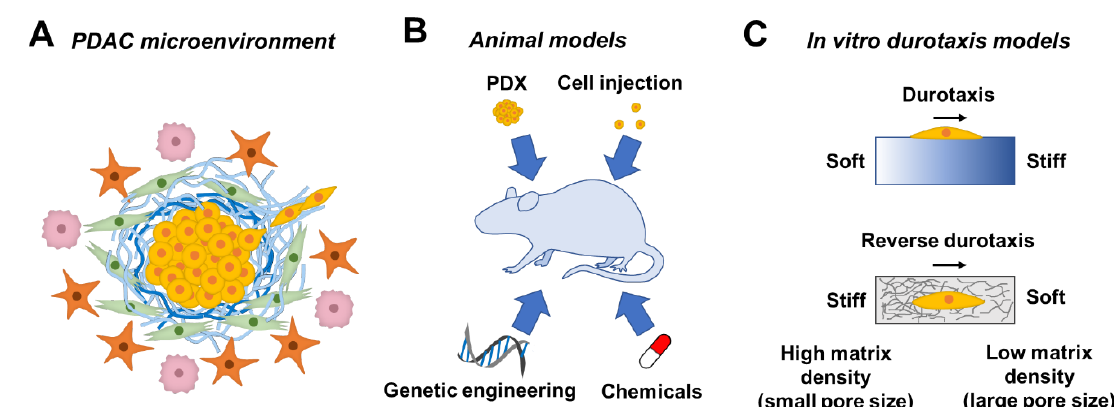
Figure 1. Schematic of ( A ) tumor microenvironment, ( B ) animal models used to study PDAC (PDX: patient-derived xenograft), and ( C ) in vitro durotaxis (or reverse durotaxis) models used to study cancer cell migration in response to stiffness gradient.